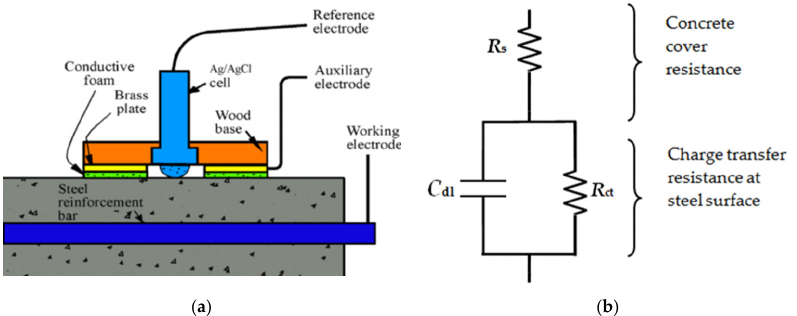
Figure 1. Scheme of ( a ) linear polarisation resistance measurement (LPR) and ( b ) Randle’s equivalent electrical circuit [19].